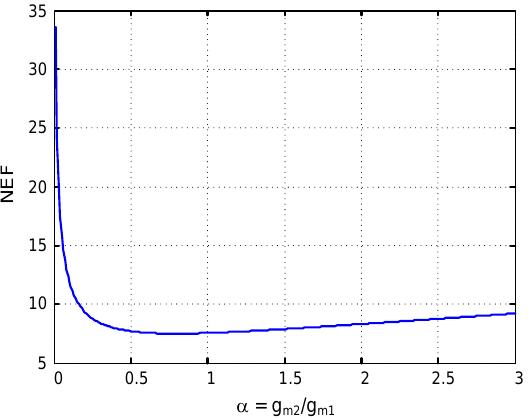
Figure 4. NEF vs transconductance ratio in the MIFN